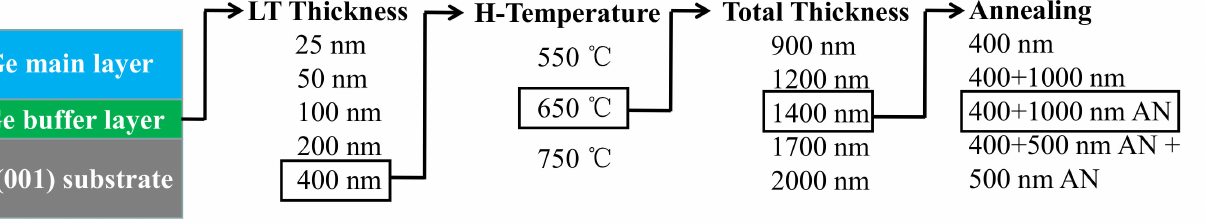
Figure 1. Simplified schematic representation of Ge epilayers on Si